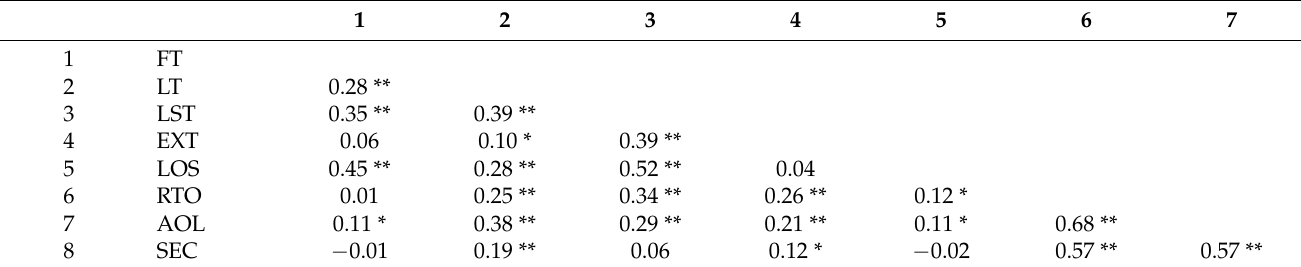
Table 2. Correlation matrix (Pearson’s r) for research indicators (N =